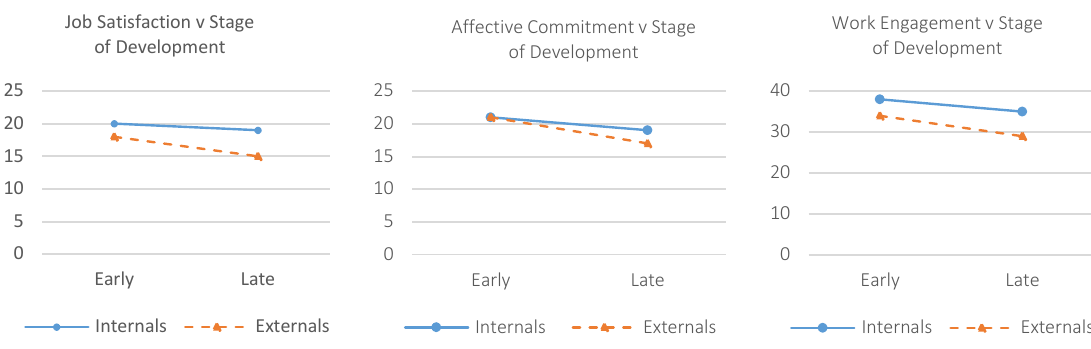
Figure 2. Relationships between the stage of development of the department on the organizational life cycle and constructs of happiness at